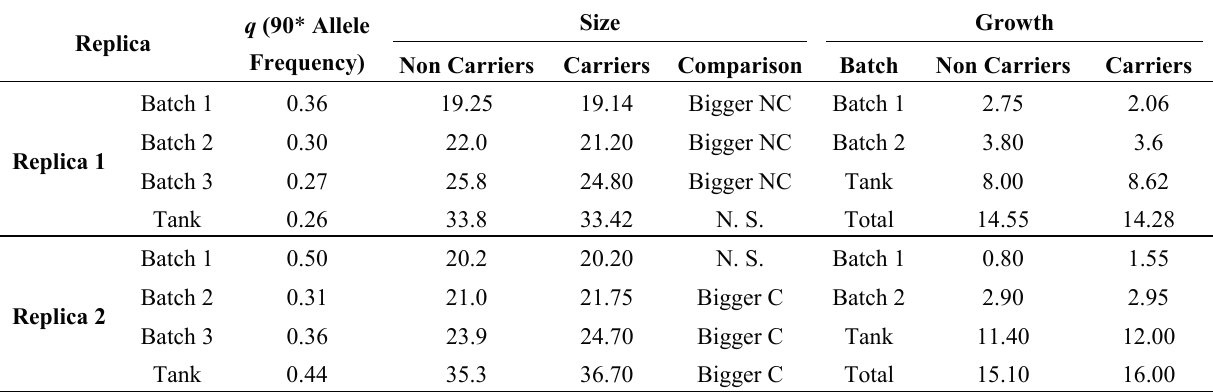
Table 2. Frequency, size (furcal length in mm) and growth of carriers of the non-native *90 allele in Hatchery I in 2012 (two